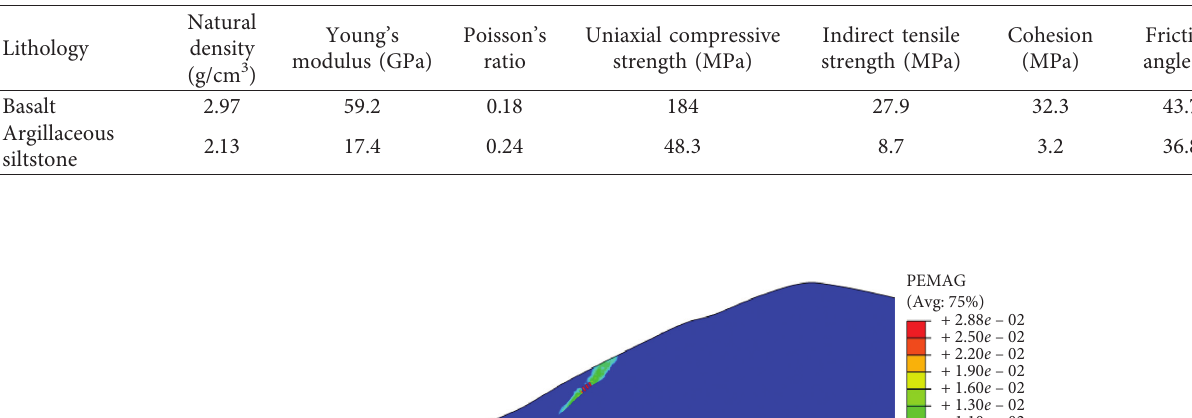
Table 3: Physical-mechanical properties of the